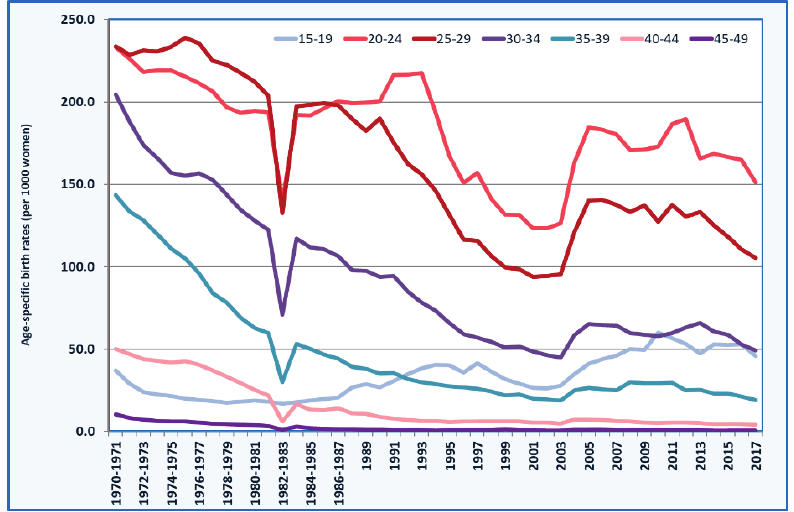
Figure 7. Dynamics of the age-specific birth rates in Azerbaijan, 1970-2017. Source: according to SSC data.